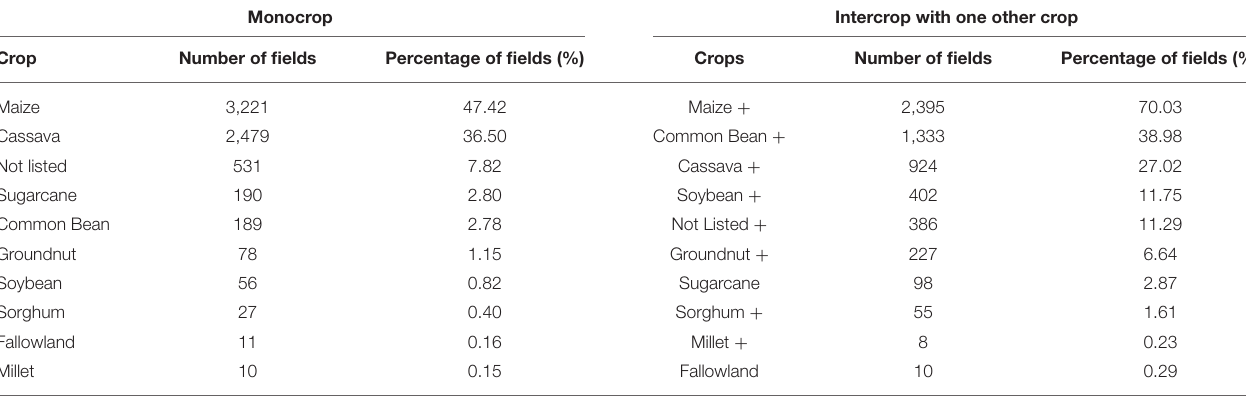
TABLE 1 | Detailed composition of the fields surveyed between August 13th and December 12th, 2019 in Busia, Kenya. Monocrop